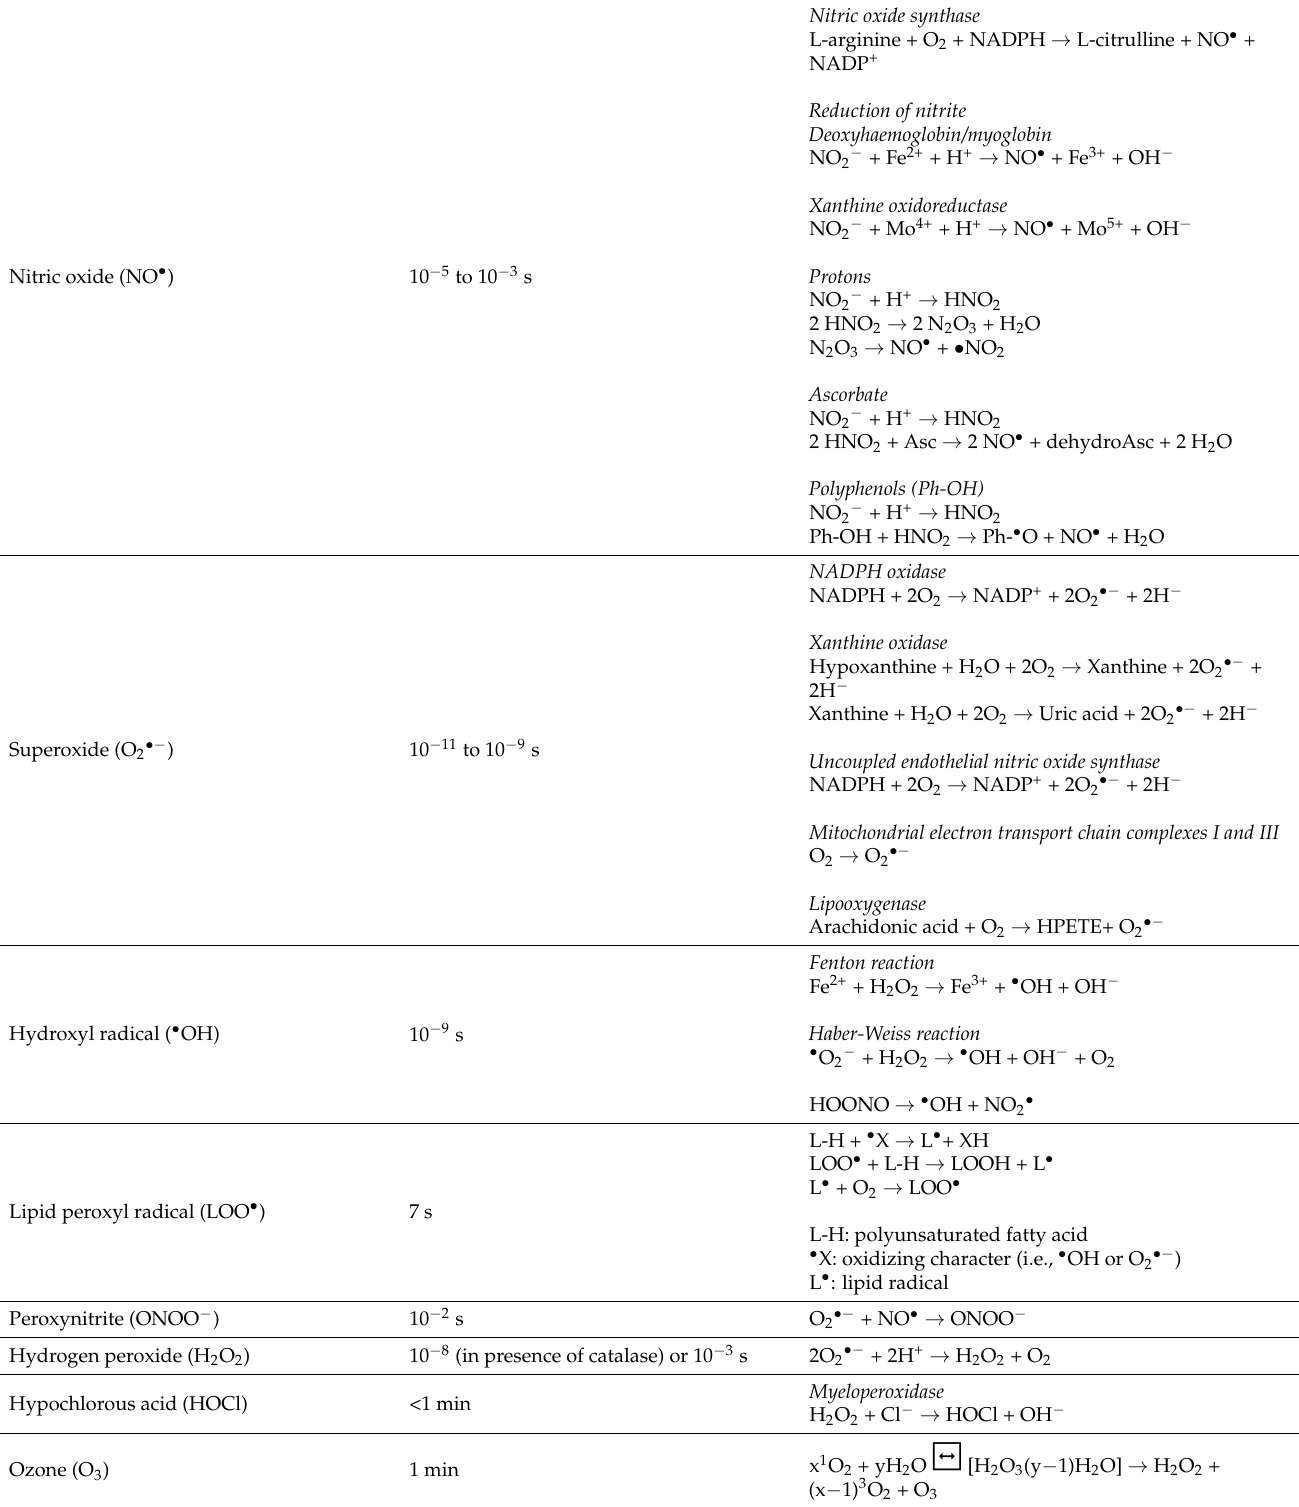
Table 1. Types and generation of reactive oxygen